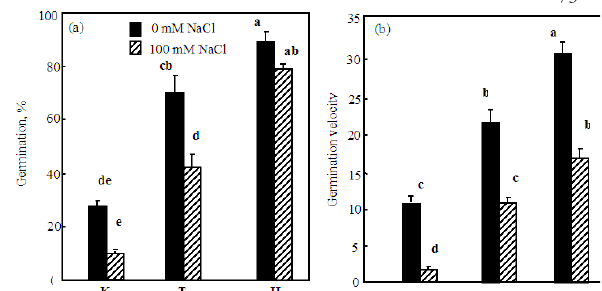
Fig. 1. Germination variability in three proveniences of C. maritimum ; (a) final germination percentage; (b) germina- tion velocity, K=Klebia provenience, T=Tabarka provenience, H=Haourea provenience. Mean values that are marked with more letters are significtly different at